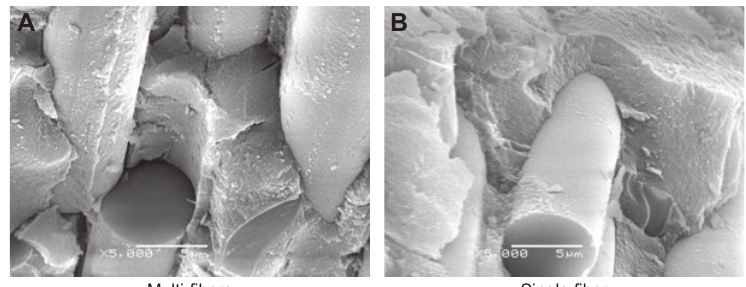
Figure 7 SEM micrographs of fi ber/matrix interface.